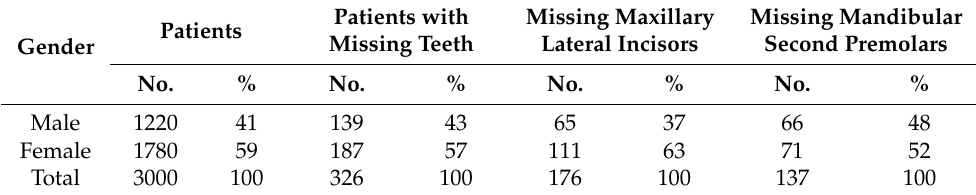
Table 1. Distribution of missing teeth by